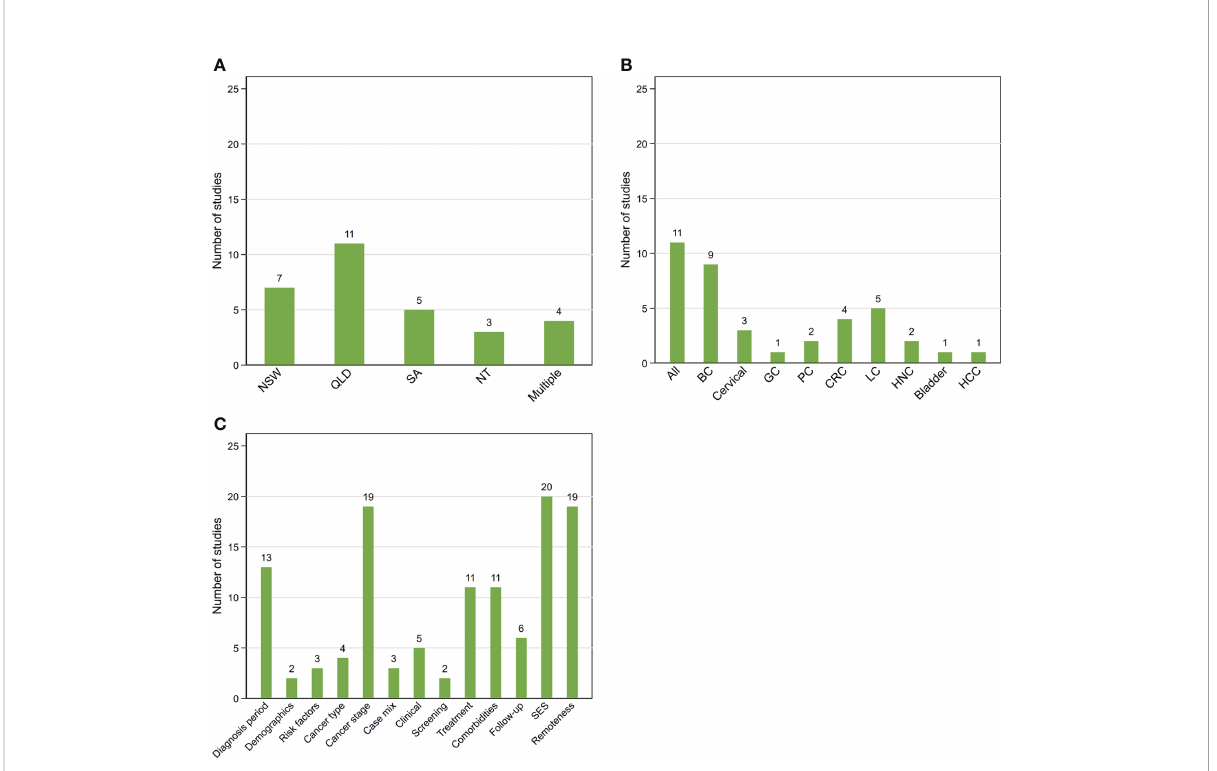
FIGURE 2 Summary of 30 included studies by location (A) , cancer type (B) and additional covariates (C) other than Aboriginal and Torres Strait Islander status, sex, and age included in survival models. NSW, New South Wales; QLD, Queensland; SA, South Australia; NT, Northern Territory; Multiple More than one state/territory (A) ; BC, female breast cancer; GC, gynecological cancers; CRC, colorectal cancer; LC, lung cancer; HNC, head and neck cancers; HCC, hepatocellular carcinoma (B) ; SES, socio-economic